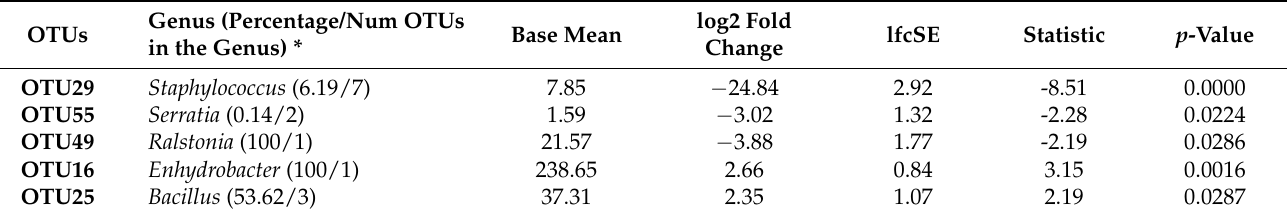
Table 3. Operational Taxonomic Units displaying a significant difference in abundance between tsetse flies with non-mature vs. mature infection with